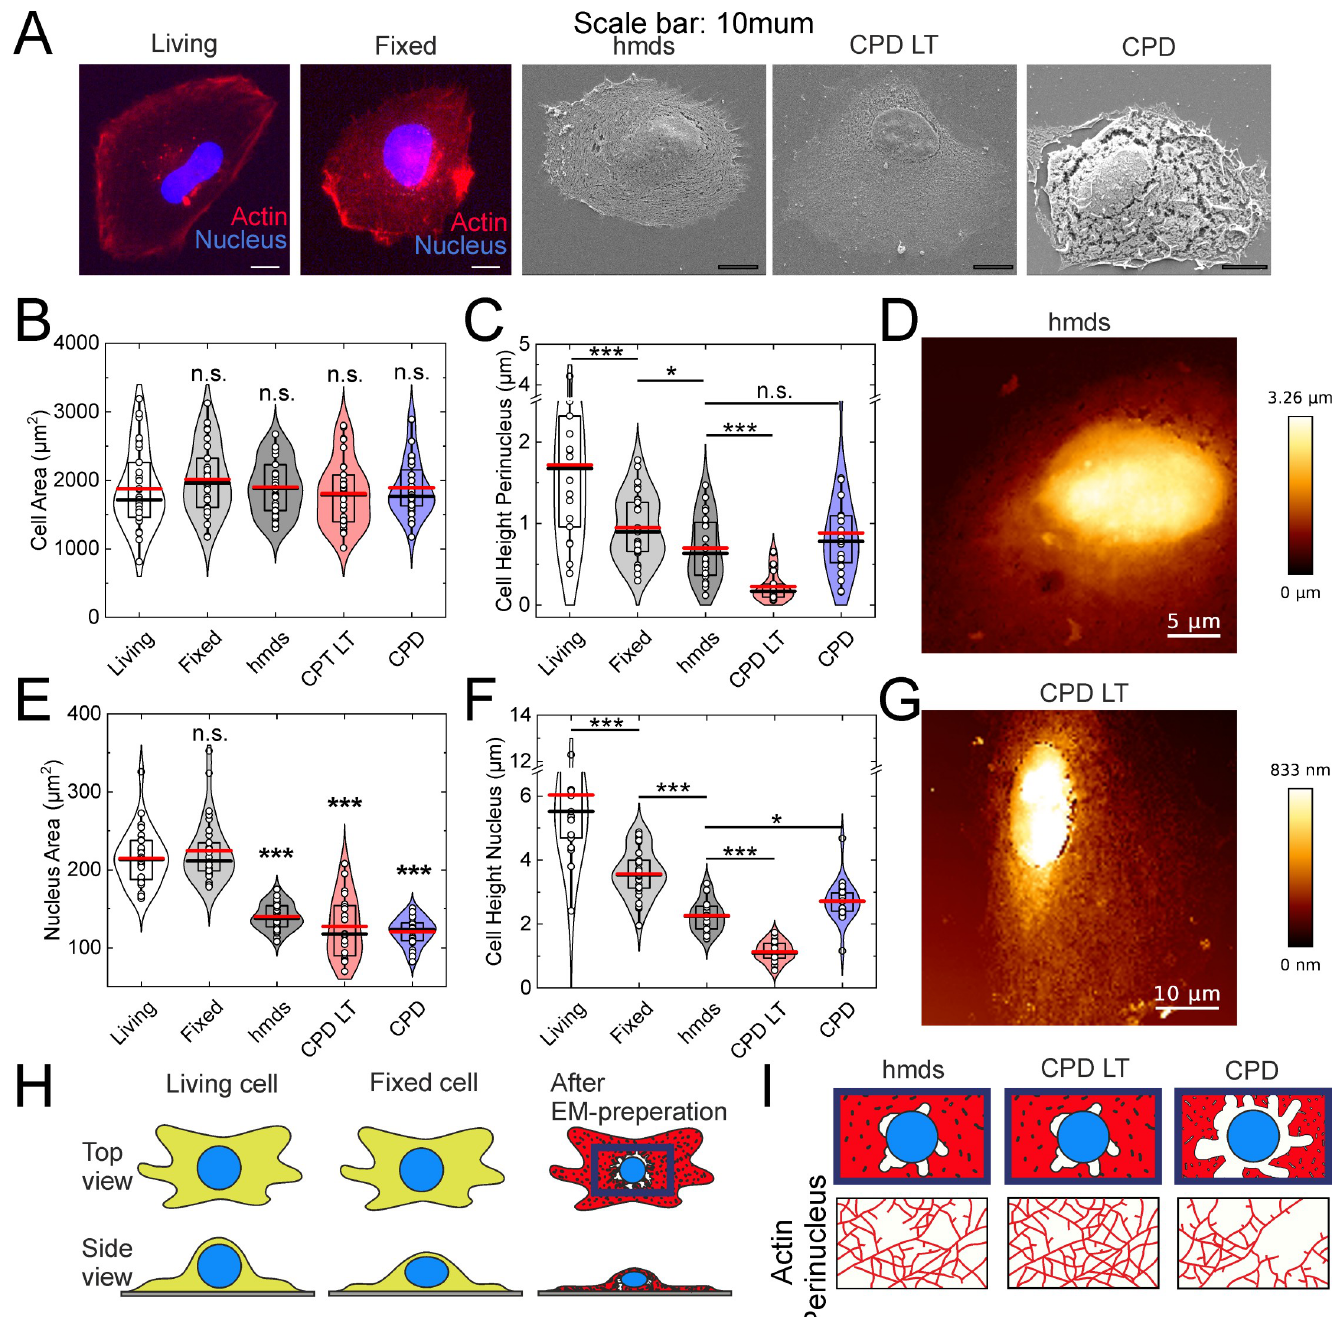
Fig 3. Influence of cell fixation and SEM drying. ( A, B, C, E, F ) Representative images (A, scale bars: 10 μ m) and quantification from fluorescence microscopy (Living, Fixed) and scanning electron microscopy (hmds, CPD-LT, CPD) of cell (B) and nucleus (E) areas, and from atomic force microscopy (as indicated) of perinucleus (C) and nucleus (F) heights. � , p < 0.05; ��� , p < 0.001; n.s., not significant; unless indicated by lines between conditions all statistical marks compare the conditions to living cells only via t-tests. ANOVA tests: p = 0.58 (B), p = 5.98 � 10 − 11 (C), p = 5.43 � 10 − 30 (E), p = 4.9 � 10 − 24 (F). ( D , G ) Representative atomic force microscopy images of cells following HMDS10 (D) and CPD-LT (G). ( H ) Schematic representations of these three main preparation steps, as living cells, fixed cells, and dried cells (after EM preparation), and ( I ) the resulting appearances of the perinucleus actin network after HMDS10, CPD-LT, and CPD. N = 31, 29, 33, 32, 28 (B, from left to right); N = 31, 29, 30, 20, 27 (E, from left to right); N = 18, 31, 20, 23, 20 (C, from left to right); N = 19, 31, 20, 23, 20 (F, from left to right).